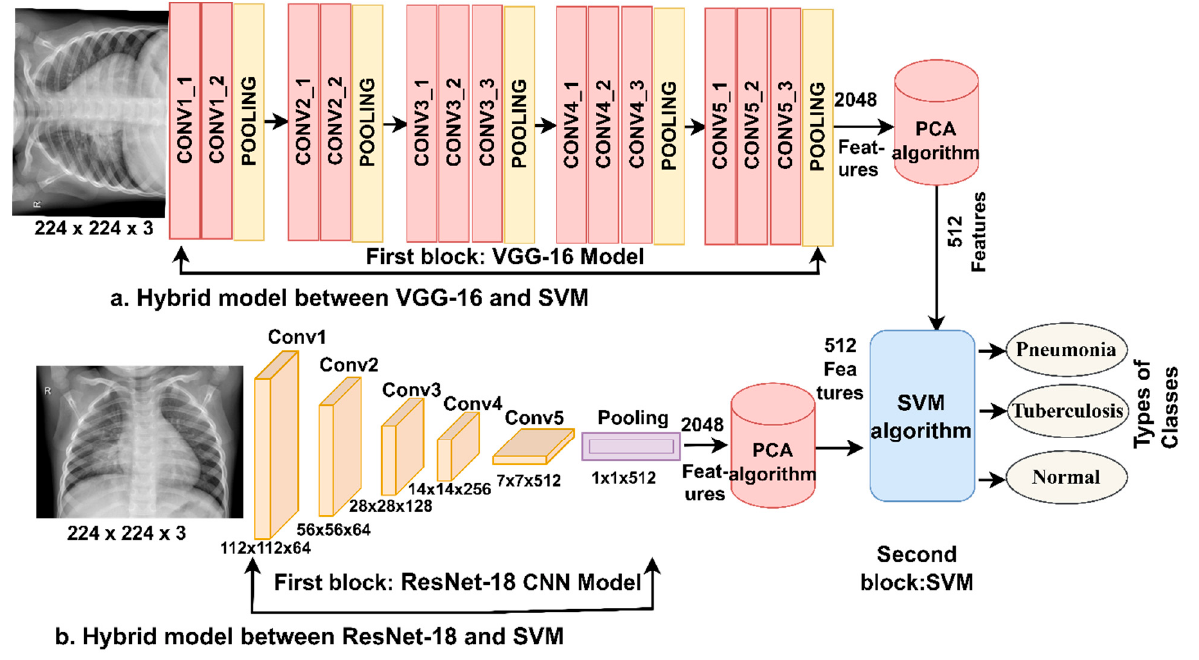
Figure 3. Structure framework of the hybrid system for early diagnosis and discrimination between pneumonia and